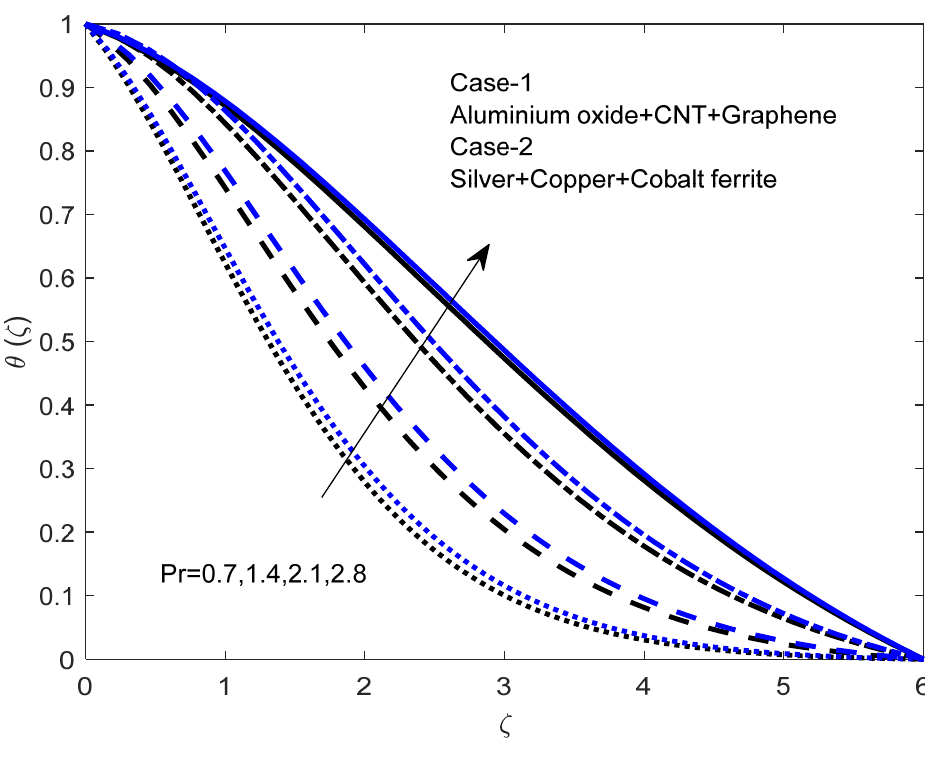
Figure 8. The effect of Pr on the temperature profile.